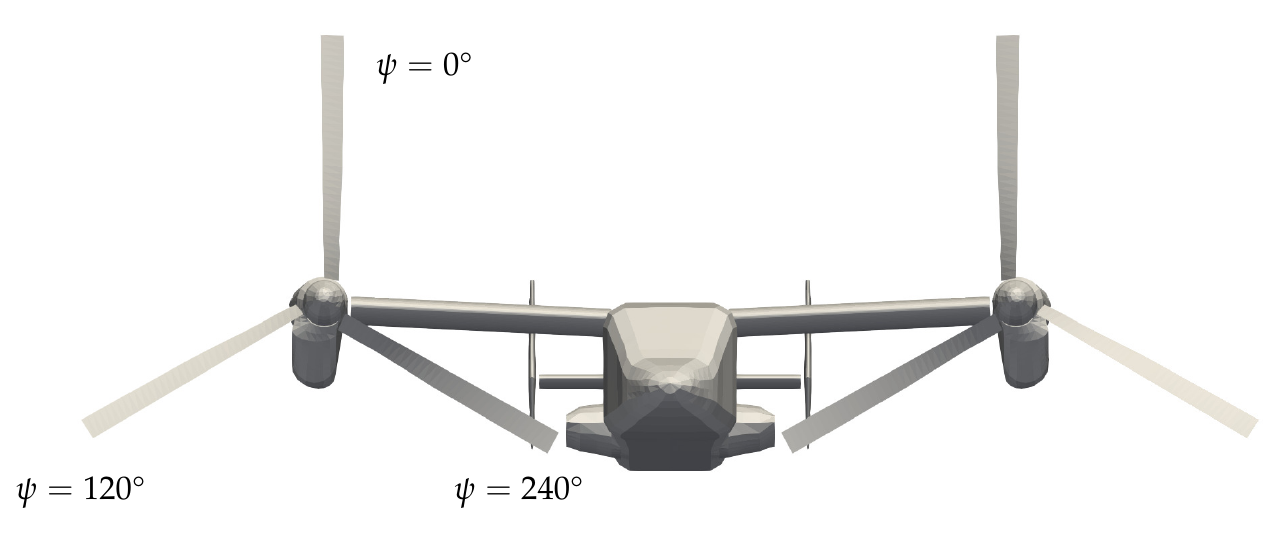
Figure 18. Convention adopted for the rotor blade azimuthal angle ψ .